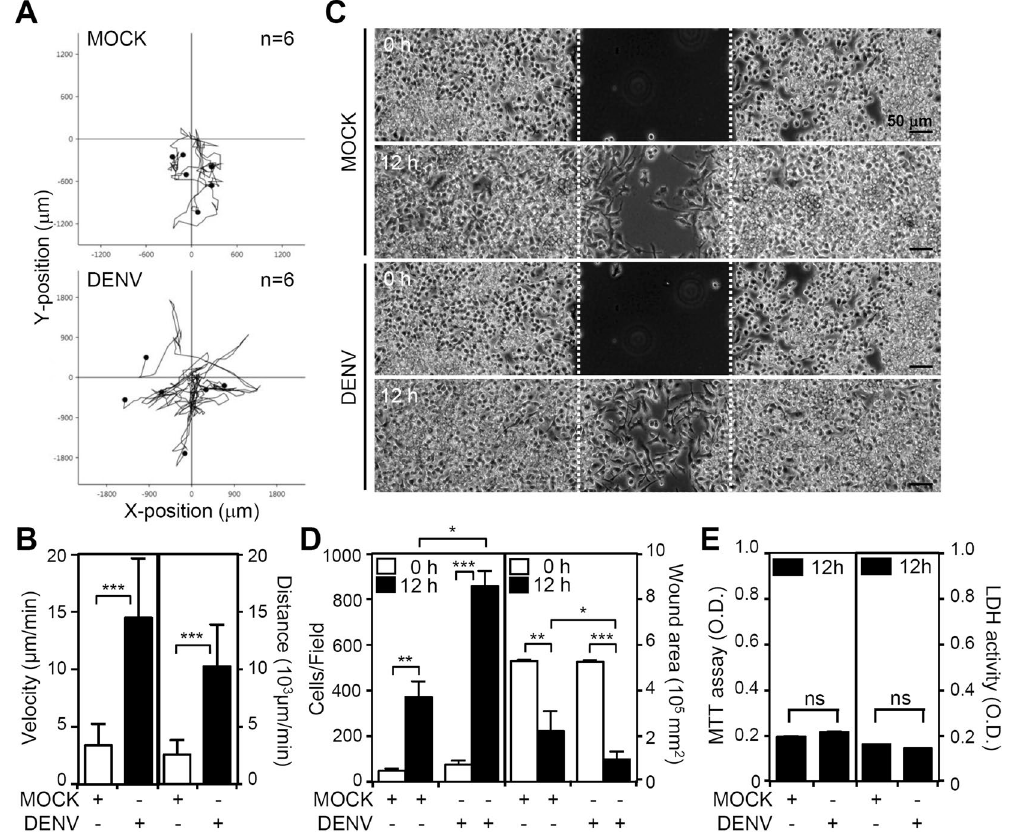
Figure 3. DENV infection increases microglial migration. ( A ) Time-lapse microscopy showed the kinetic tracking of cell migration in DENV 2-innoculated BV2 cells (n = 6) for 12 h. ( B ) Cell tracking analysis showed the velocity and distance of the migrated cells. ( C ) The wound-healing assay and ( D ) the measurement of the migrating cell number and wound area displayed cell migration. ( E ) The MTT and LDH assays showed cell viability and cytotoxicity, respectively, of cells inoculated with DENV. All quantitative data are shown as the means ± SD from three independent experiments. * p < 0.05, ** p < 0.01, and *** p < 0.001. ns, not